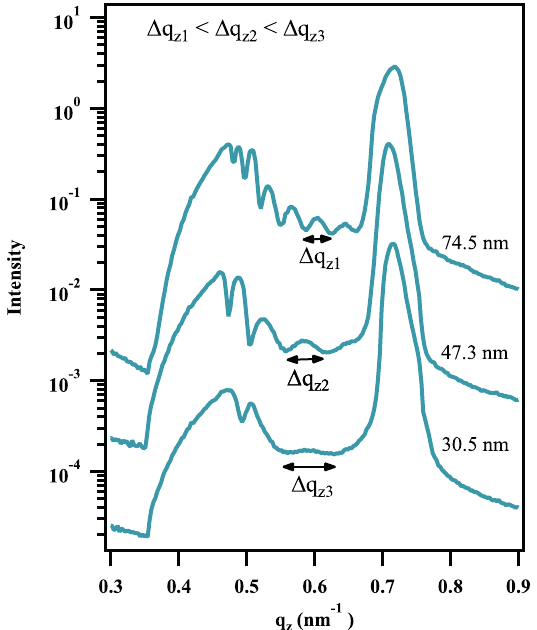
Figure 12. GISAXS line cuts in q z -direction of PMMA brushes with different layer thicknesses. The distance between two oscillation minima in the line profiles of PMMA brushes ( ∆ q z ) increases with decreasing layer thickness.